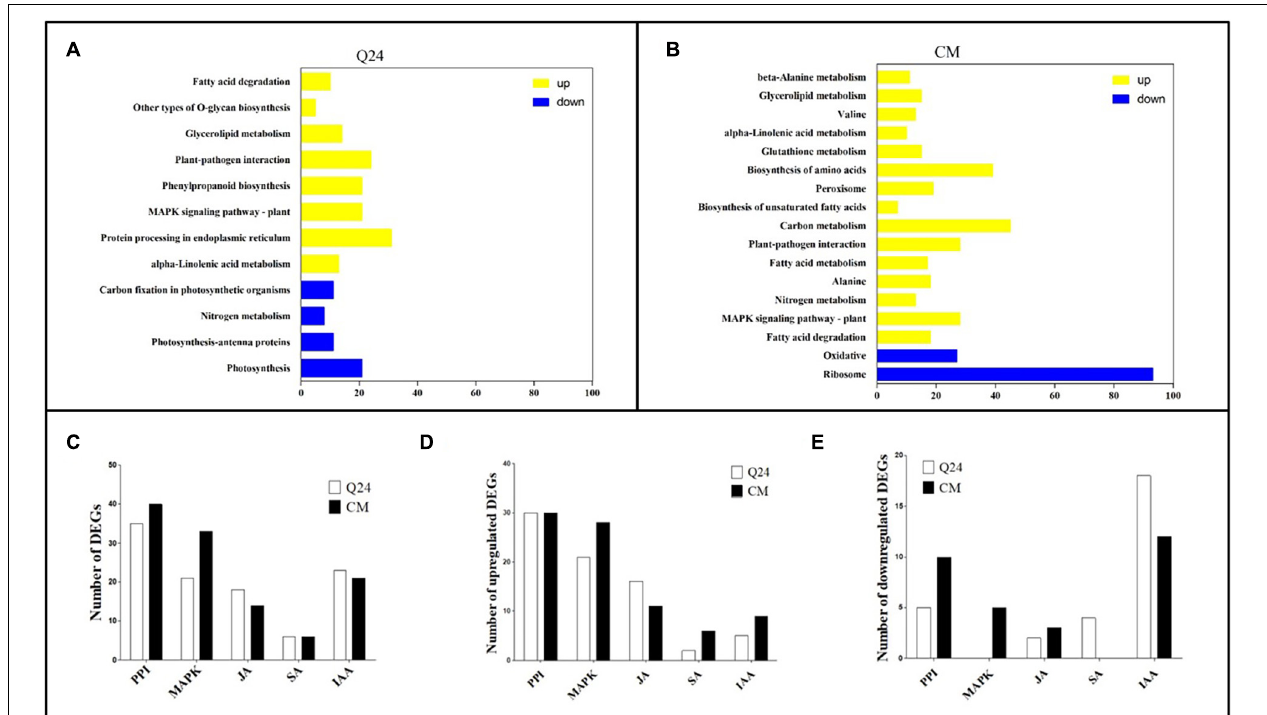
FIGURE 3 | Kyoto Encyclopedia of Genes and Genomes (KEGG) enrichment analysis in responding to the M. incognita infection of Q24, CM. DEGs were classified into pathway categories with high classification stringency (adjusted P < 0.05). The horizontal ordinate represents the number of genes in the category. (A) KEGG terms of DEGs in Q24; (B) KEGG terms of DEGs in CM. Yellow indicated upregulation and blue indicated downregulation; (C) the DEGs mapped to hormone metabolism and plant pathogen interactions of Q24 and CM responding to infection (adjusted P < 0.05); (D) the number of upregulated DEGs and downregulated DEGs mapped to hormone metabolism and plant pathogen interactions of Q24 (adjusted P < 0.05); (E) the upregulated DEGs and downregulated DEGs mapped to hormone metabolism and plant pathogen interactions of CM (adjusted P < 0.05). PPI, plant-pathogen interactions; MAPK, mitogen-activated protein kinase signaling